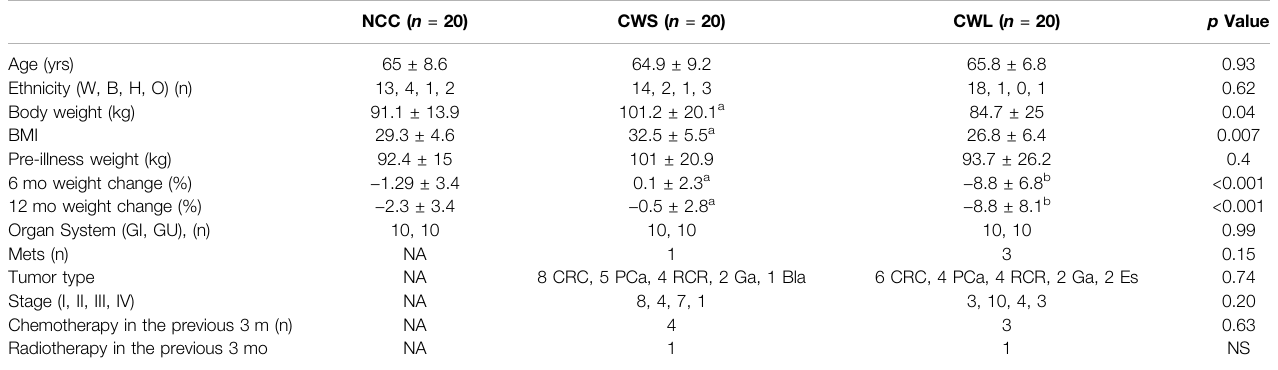
TABLE1| SubjectCharacteristics.ReasonsforsurgeryingroupNCC(n):benignprostatichypertrophy(Sinetal.,2021),benigncolonictumor(ZhangandLi,2012),Colonic diverticulitis (Sin et al., 2019a), abdominal hernia (Baracos et al., 2018).